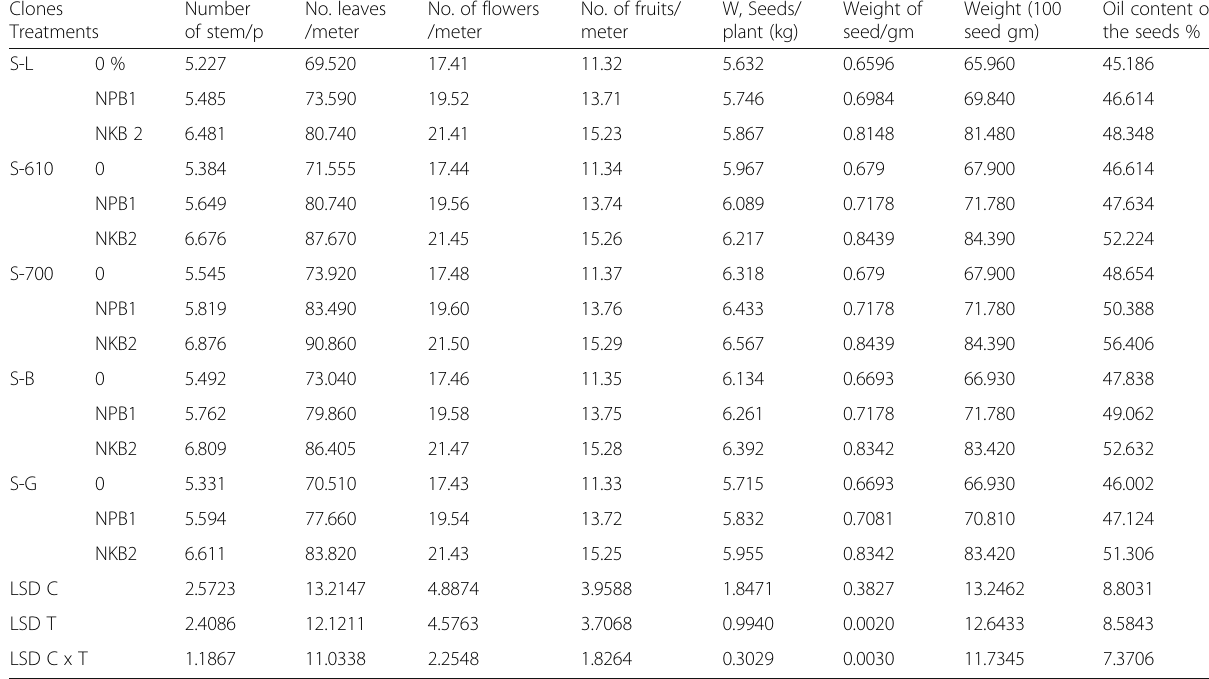
Table 5 Effect of NPB rates on yield of clones jojoba plants at 13 years Clones Treatments